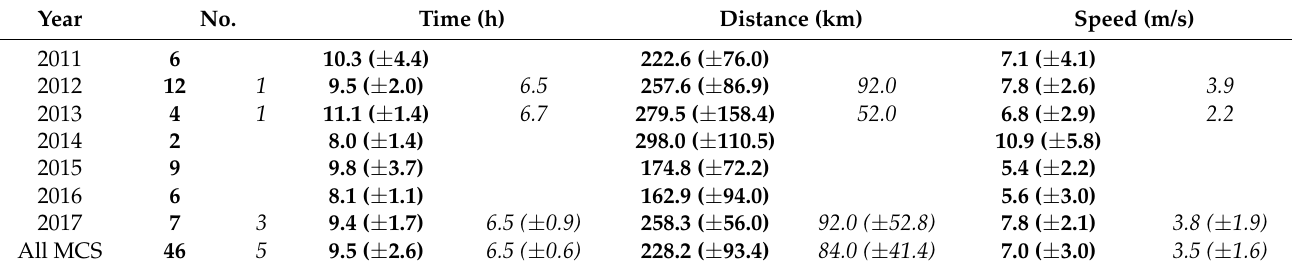
Table 2. As Table 1, but for MCS in the Band B.